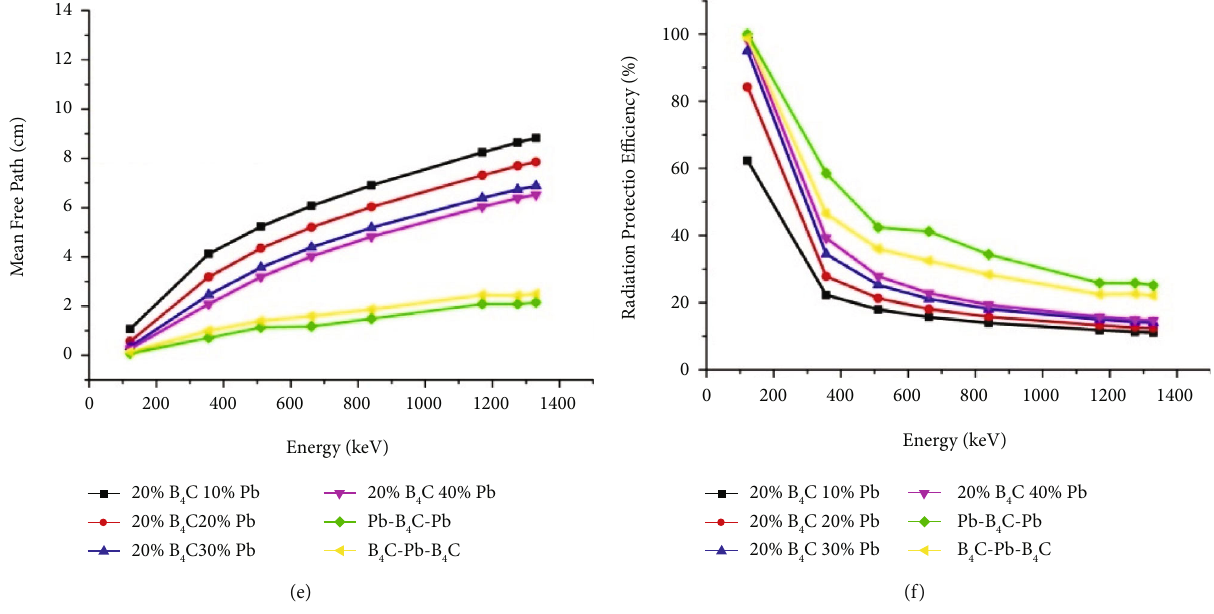
Figure 4: (a) Mass attenuation coe ffi cient vs gamma radiation energy. (b) Linear attenuation coe ffi cient vs gamma radiation energy; (c) half value layer (HVL) vs gamma radiation energy; (d) tenth value layer vs gamma radiation energy (TVL); (e) mean free path (MFP) vs gamma radiation energy, and (f) radiation protection e ffi ciency vs gamma radiation